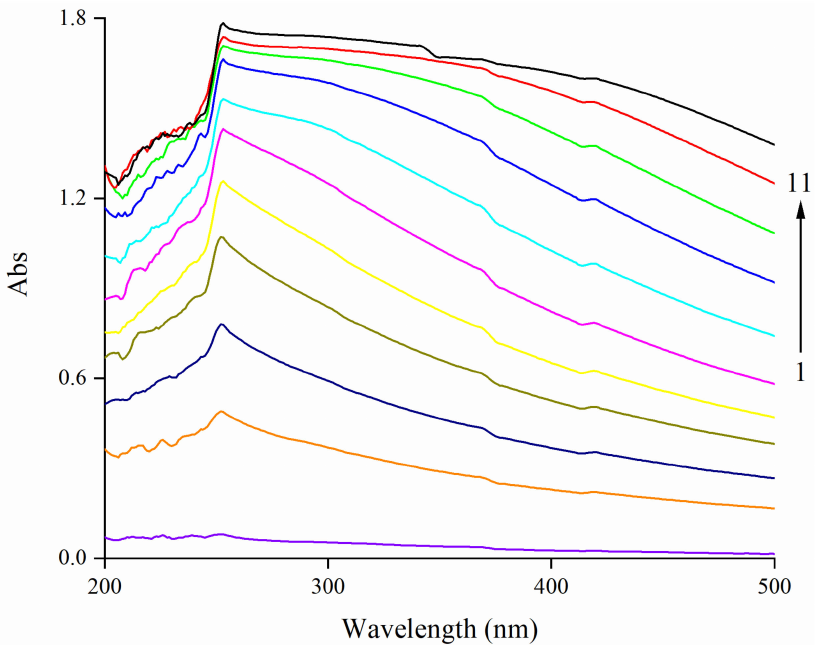
Figure 1. Effect of EA on the UV–Vis spectroscopy of zein. Note: EA: ellagic acid; the concentration of zein is 0.05 mg/mL; curve 1: violet curve (0 mg/mL EA); 2: orange curve (0.1 mg/mL EA); 3: navy curve (0.2 mg/mL EA); 4: dark yellow curve (0.3 mg/mL EA); 5: yellow curve (0.4 mg/mL EA); 6: magenta curve (0.5 mg/mL EA); 7: cyan curve (0.6 mg/mL EA); 8: blue curve (0.7 mg/mL EA); 9: green curve (0.8 mg/mL EA); 10: red curve (0.9 mg/mL EA); 11: black curve (1.0 mg/mL